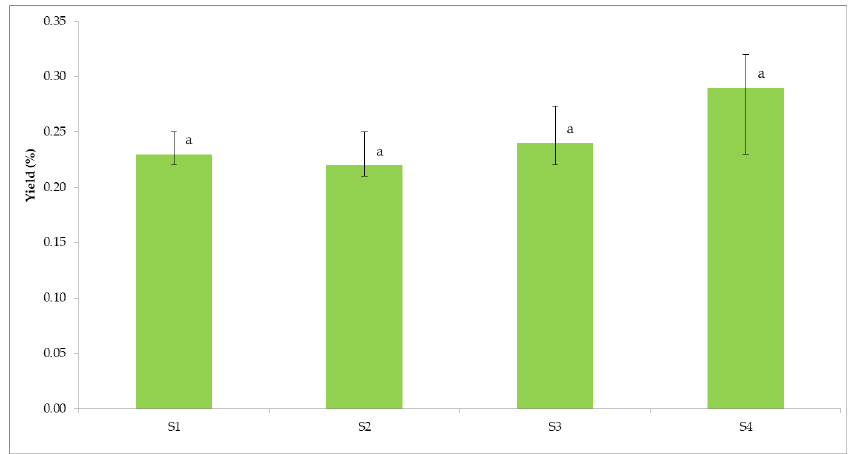
Figure 2. Effect of the growing substrates on sage essential oil (EO) yield (%). Vertical bars (means of the four substrates) with the same letters indicate not significant differences at p ≤ 0.05 (Duncan’s Multiple Range Test—DMRT). Table 4. Amount (%) of volatile compounds, grouped on the basis of their chemical characteristics and identified in the EO extracted by hydrodistillation from fresh leaves of sage plants cultivated with the four growing substrates. Compound Similarity